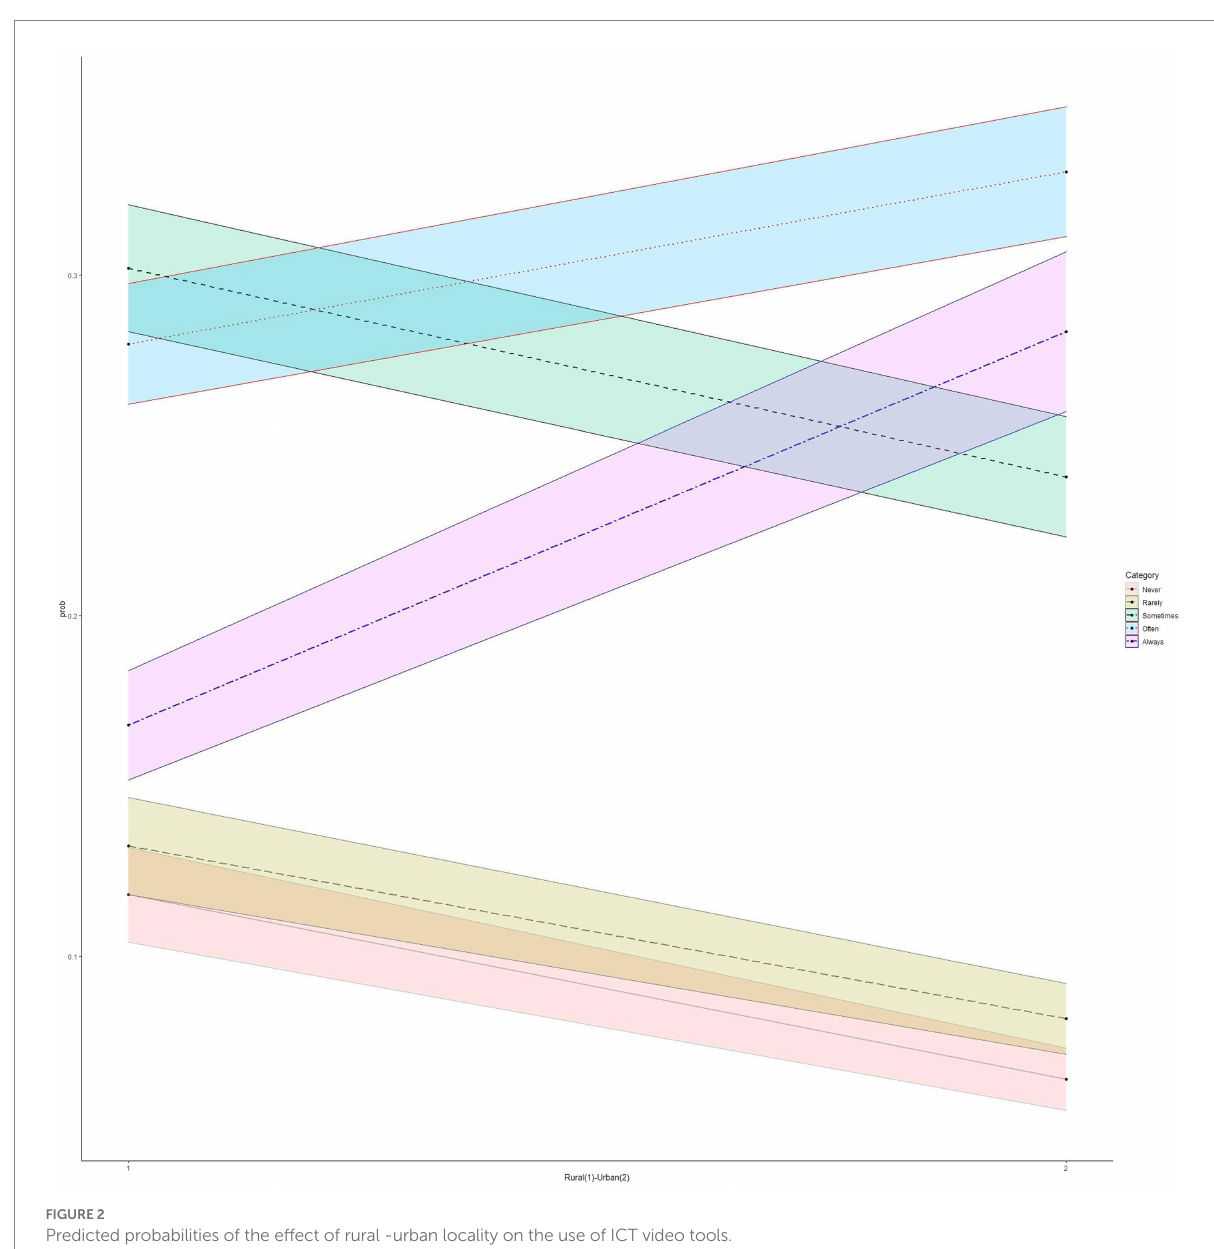
FIGURE 2 Predicted probabilities of the effect of rural -urban locality on the use of ICT video